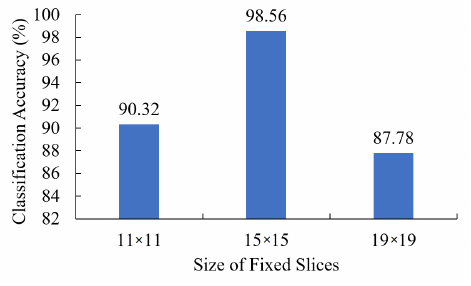
Figure 9. The classification accuracy of the Dual-CNN with the slices of different sizes.